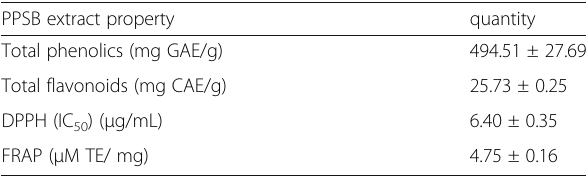
Table 1 Total phenolics, flavonoids and antioxidant activity of the P. pluviosa aqueous alcohol extract